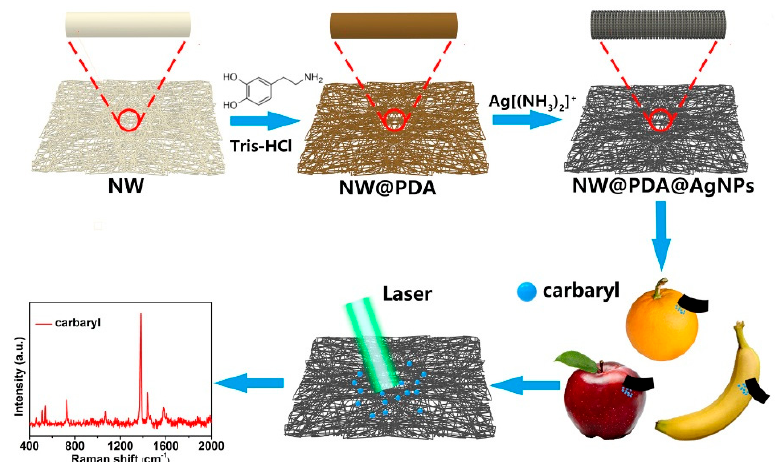
Figure 1. Schematic of the fabrication of non-woven polydopamine/silver nanoparticle (NW@PDA@AgNPs) fabrics for highly sensitive detection of carbaryl pesticide